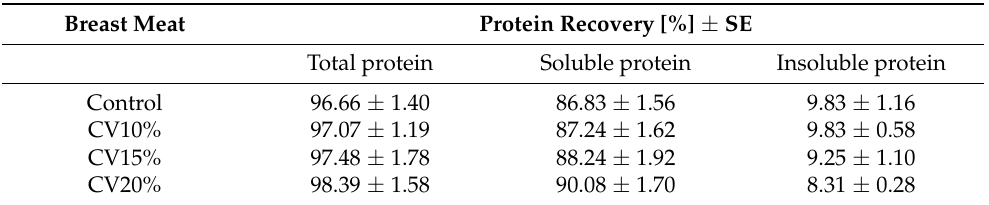
Table 7. Insoluble protein and soluble protein after in vitro digestion of breast muscle of broilers chickens fed different levels of C. vulgaris for 40 days. Data shown are mean ±